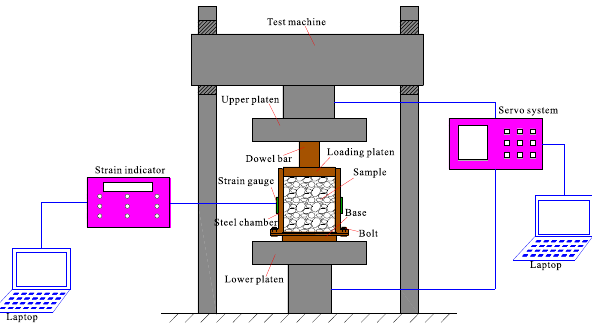
Figure 2. Schematic diagram of test system.